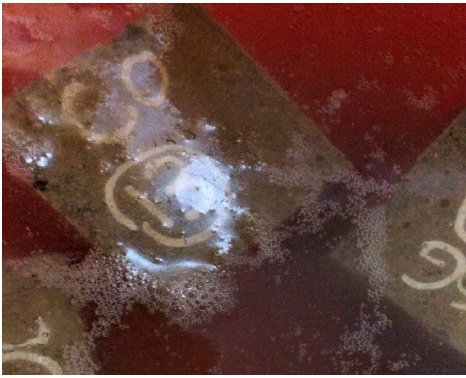
Figure 5. Samples immersed in acid solution.